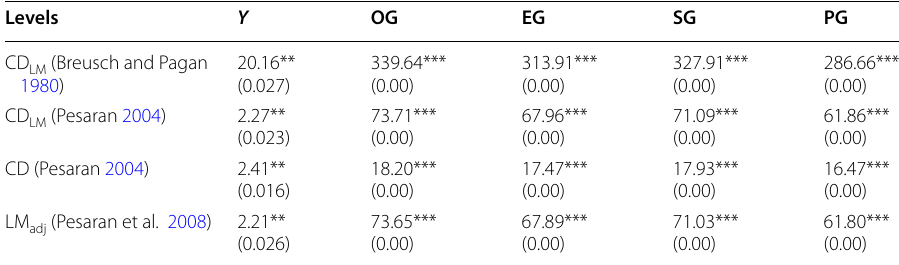
Table 1 Results of cross-sectional dependence tests